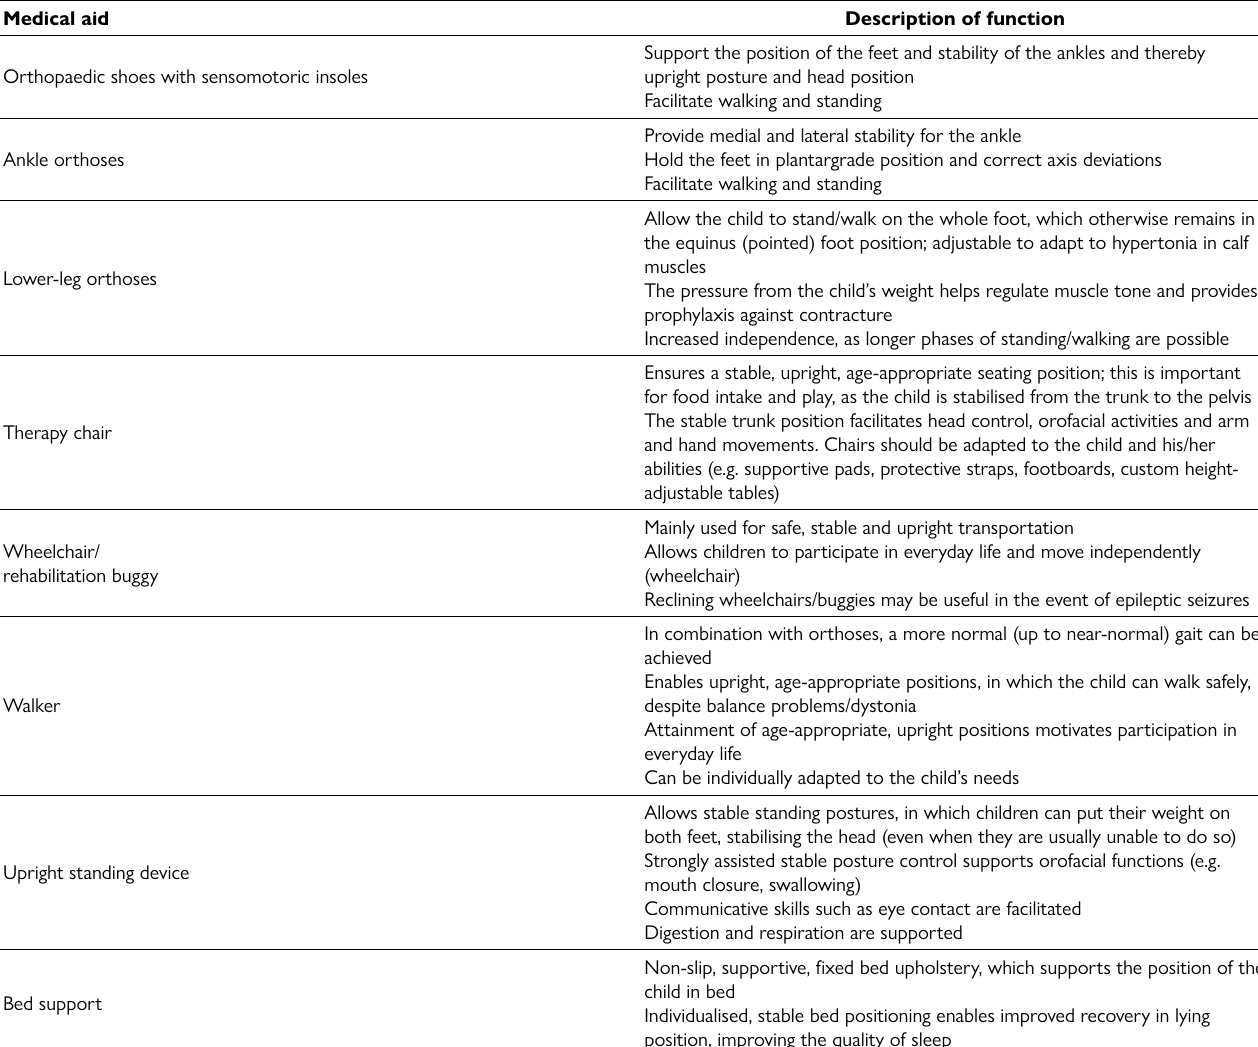
Table 2. Description of the main tools used, effects observed, and challenges encountered at the Paediatric Physiotherapy Practice in Hamburg,